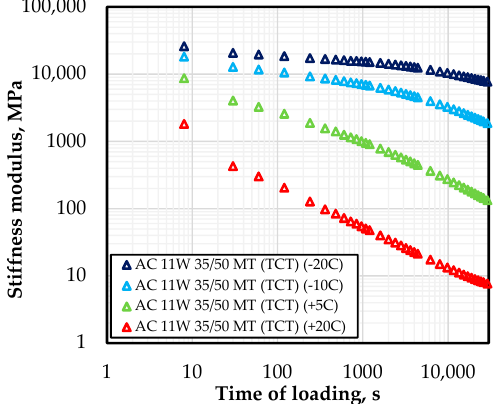
Figure 8. Creep test results—stiffness curves for AC 11W 35/50 MT, only for TCT.